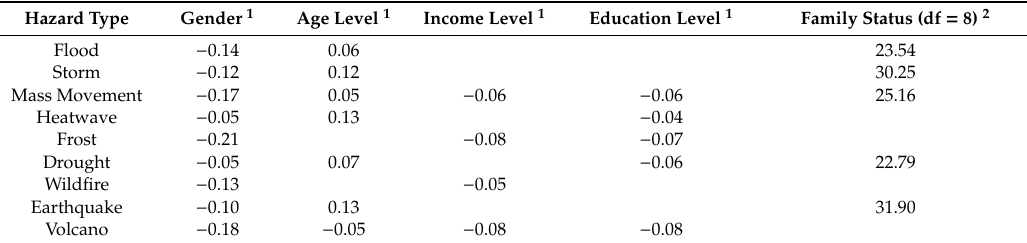
Table 4. Correlations between demographic variables and